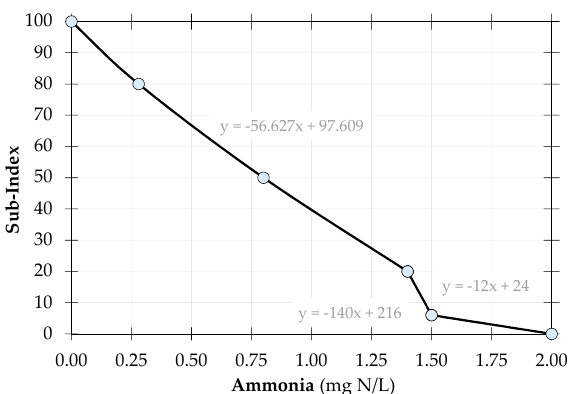
Figure 2. Sub-index rating curve for ammonia (NH 3 ) as an example of the graphically established parameter rating curves. Table 3. Universal Water Quality Index (UWQI) Input Parameters and Relevant Weightage Coe ffi cients. Water Quality